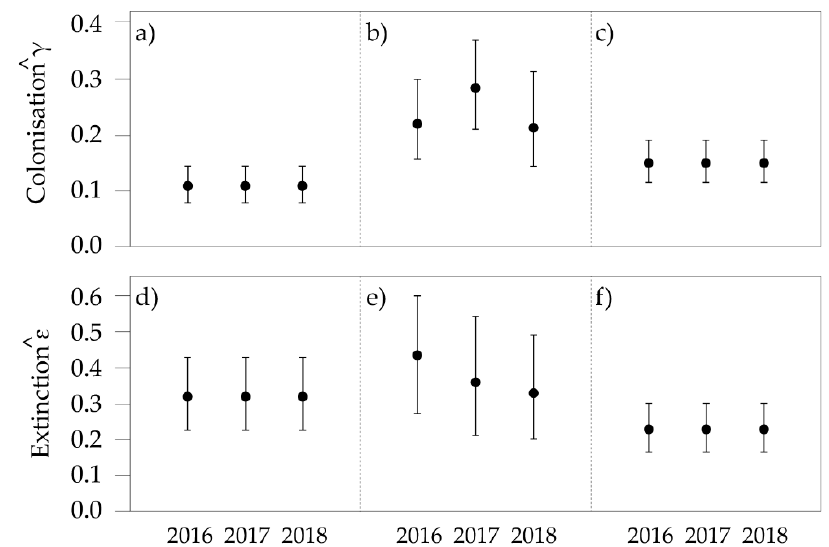
Figure 7. Estimated probabilities of colonisation ( γ ) and extinction ( ε ) for Isoodon ( a , d ), Perameles ( b , e ), and Potorous ( c , f ) during the 2016, 2017, and 2018 transitions. Central mark represents the predicted estimate and bars represent the 95% confidence interval.